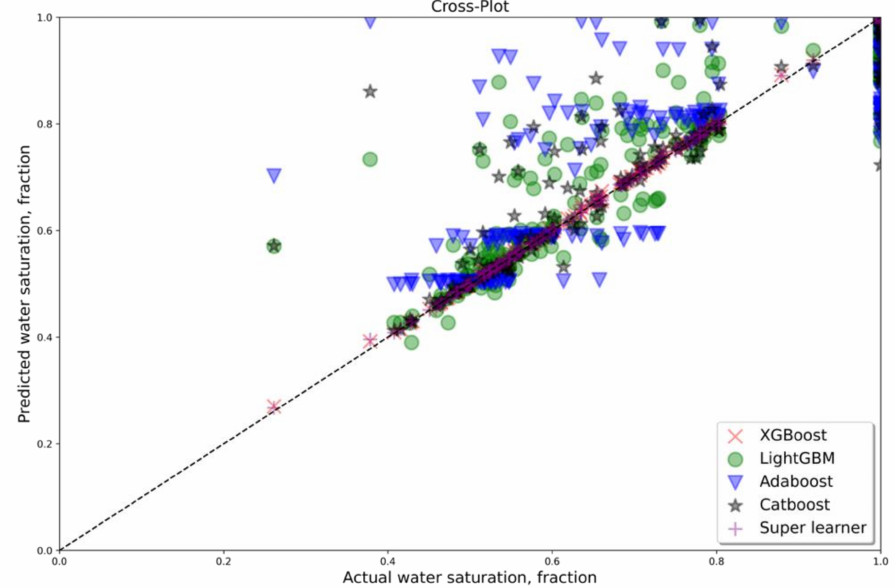
Figure A4. Cross plot for water saturation prediction results by different algorithms (Well